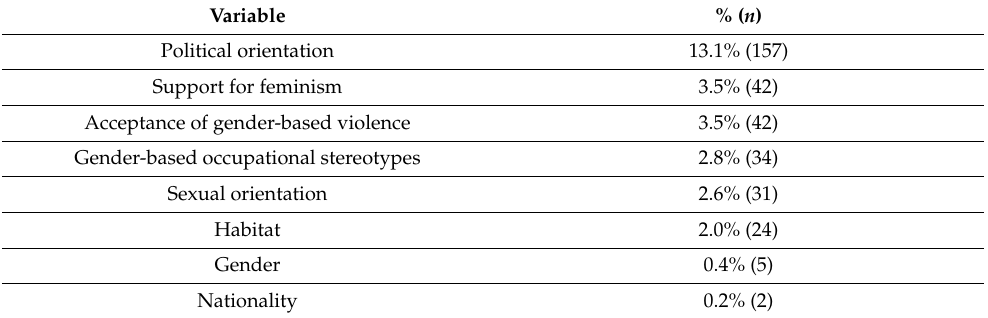
Table A3. Missing data.